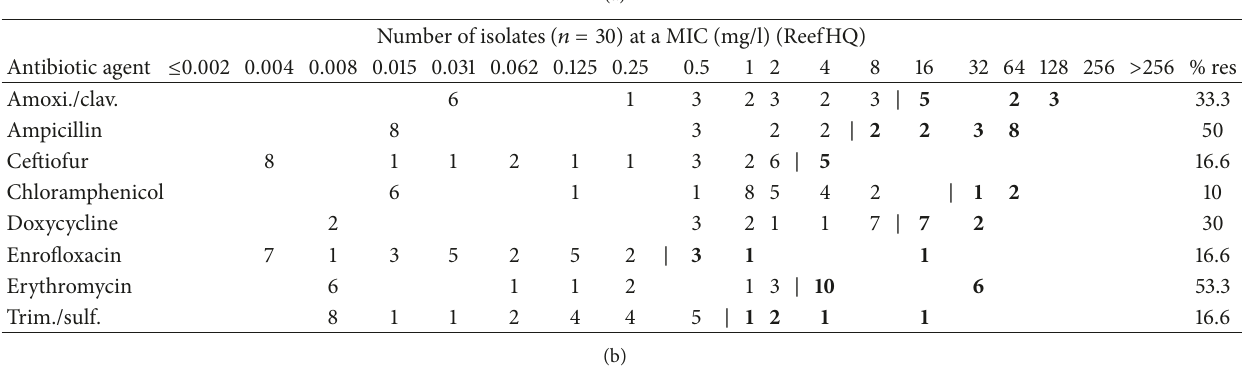
Table 2: Number of isolates from the four sampling sites 1 at a minimum inhibitory concentration (MIC 2 ) in mg/l against eight antibiotics. (a) Number of isolates (𝑛 = 30) at a MIC (mg/l) (ReefHQ)